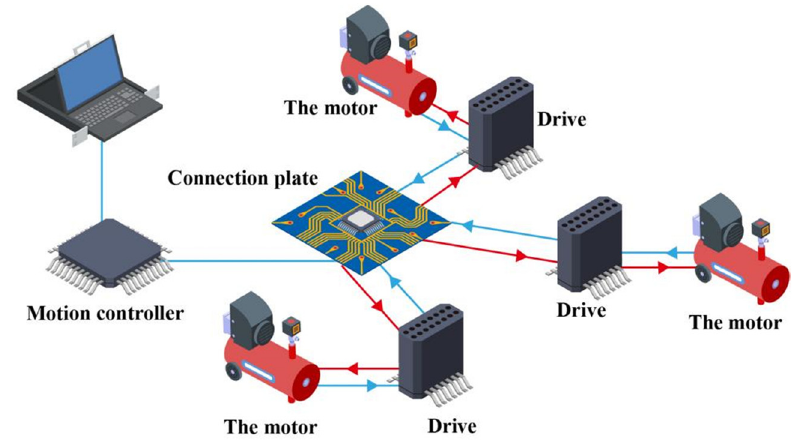
Figure 1: Schematic diagram of the robotic arm control